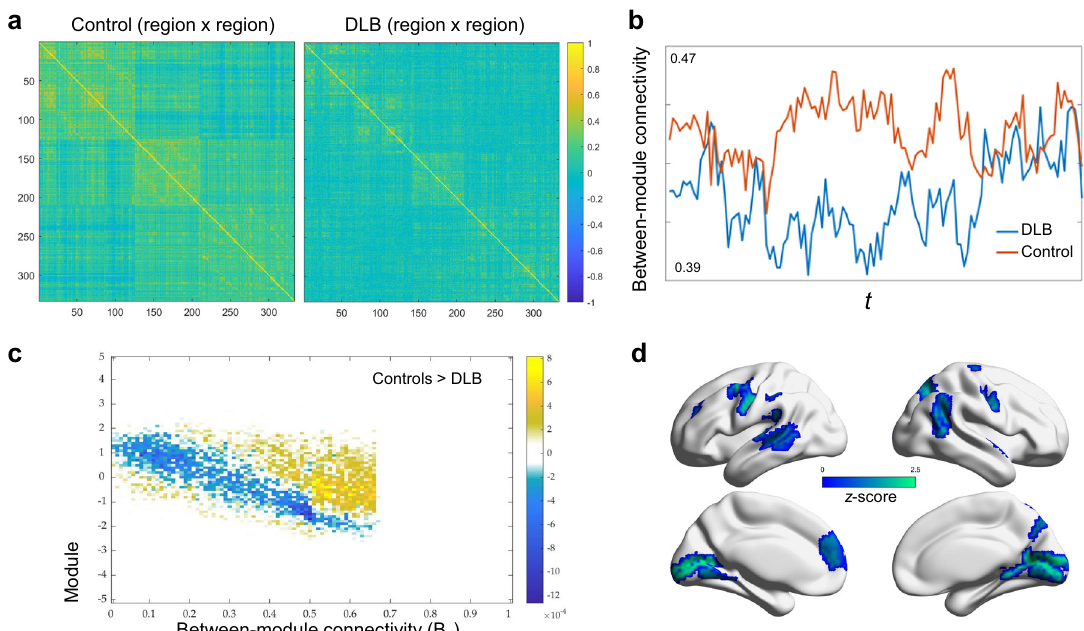
Fig. 2 DLB characterised by less integrated dynamic network topology. a Time averaged connectivity matrices derived from multiplication of temporal derivatives of activation time series demonstrate reduced long-range functional connections and more segregated, modular structure in DLB compared to controls. b Time varying participation coef fi cients also demonstrate prolonged periods of reduced time- resolved participation (between-module connectivity) between DLB and control over duration of scan (representative region in visual cortex shown). c The cartographic pro fi le of the network demonstrating higher network segregation in patients with DLB, as demonstrated by a greater number of regions over time (re fl ected by higher intensity on the histogram) occupying states of lower between-module connectivity (leftward shift) and equivalent or higher within module connectivity. d Topographic mapping of reduced participation in DLB demonstrates prominent involvement of medial, frontal, parietal and occipital regions.